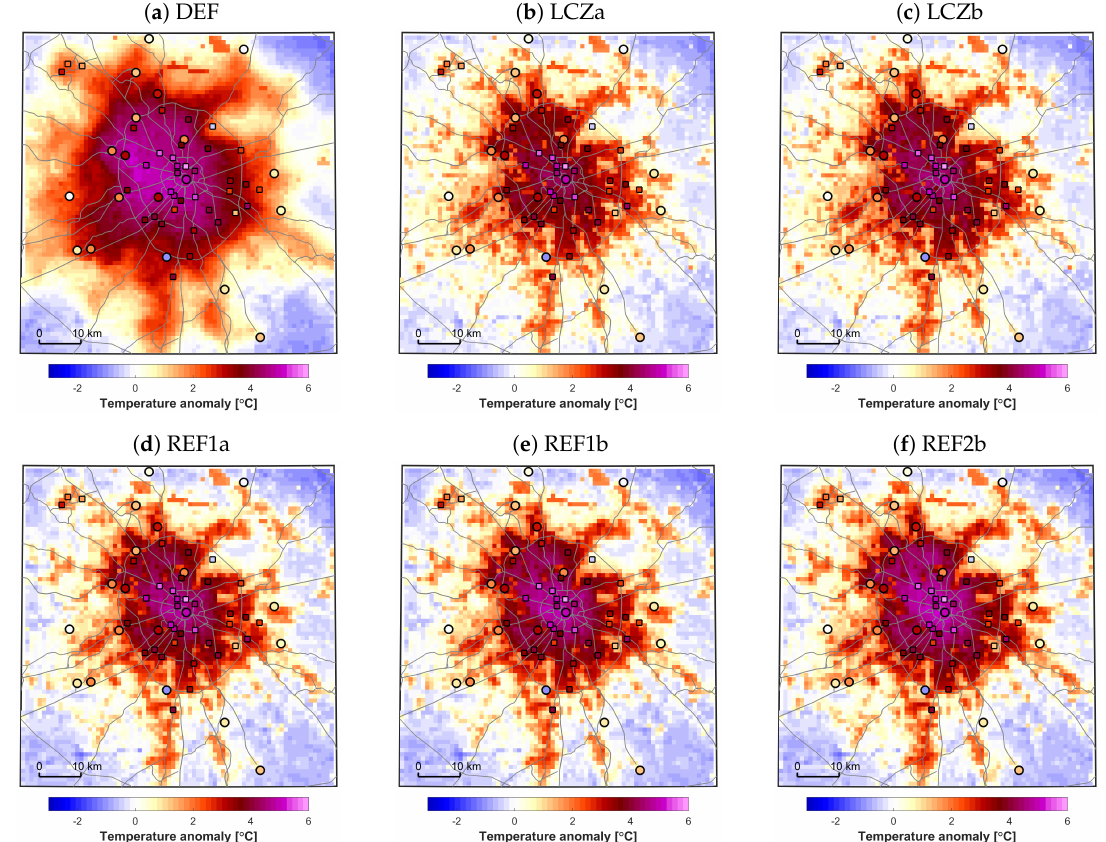
Figure 9. Spatial distribution of the nocturnal (21, 00 UTC) UHI intensity (temperature anomaly with respect to the mean rural value), averaged over the selected sub-period in August 2017 according to observations at WSs (circles), AAQS (squares) and modelling results (colored background) for DEF ( a ), LCZa ( b ), LCZb ( c ), REF1a ( d ), REF1b ( e ), REF2b ( f ) model